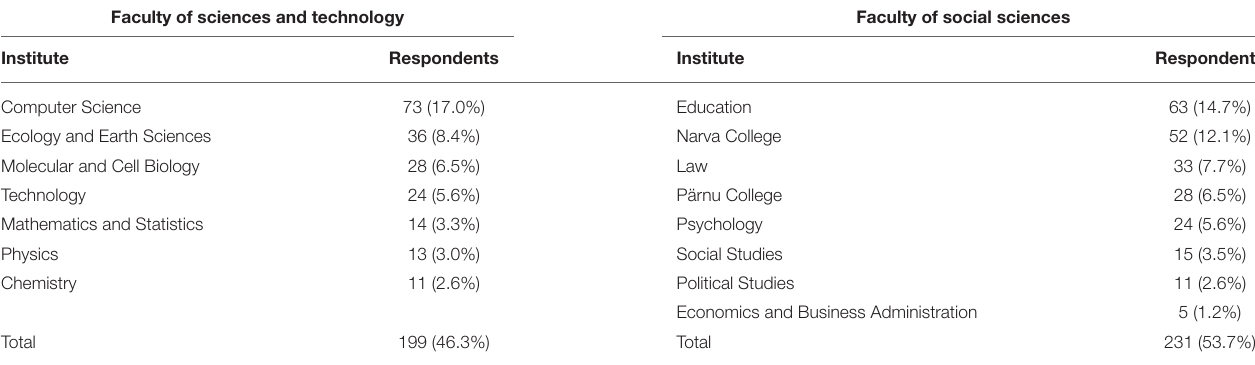
TABLE 1 | Distribution of respondents by institute and